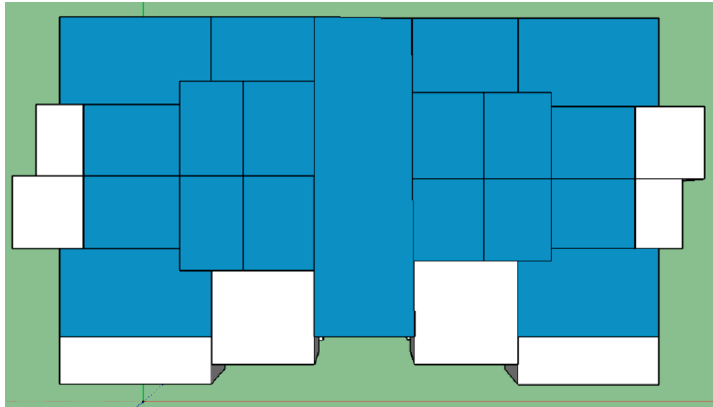
Figure 7. A view of the building corresponding to configuration 2.